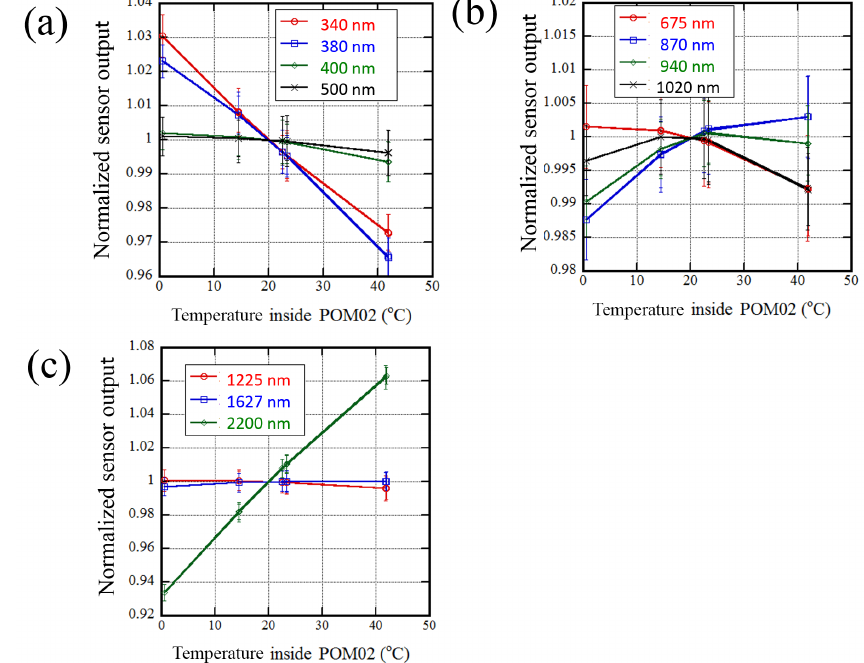
Figure 3. Same as Fig. 2 but for POM-02